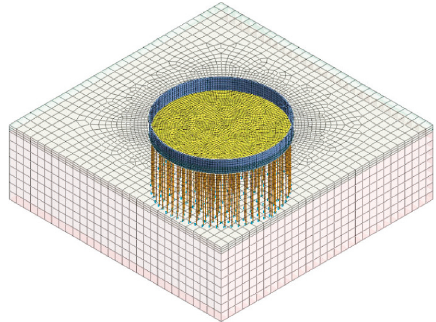
Figure 3: Numerical calculation 3-D model for SST.